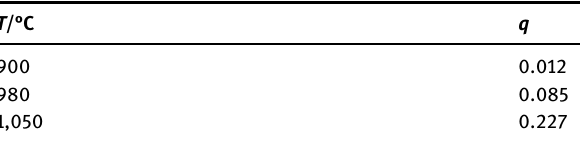
Table 3: Notch sensitivity under di ff erent